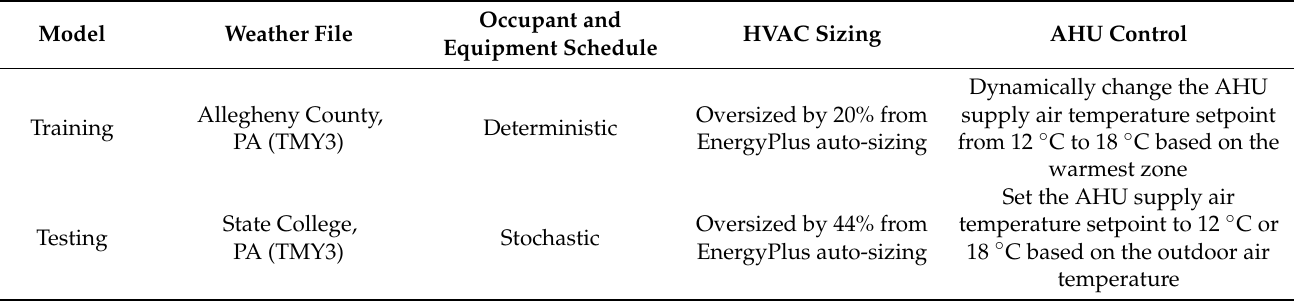
Table 4. Differences between the training model and the testing